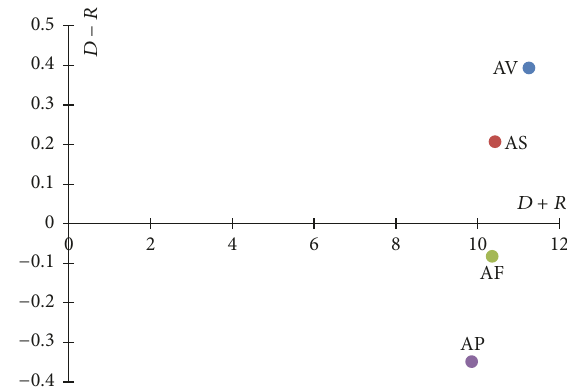
Figure 5: Cause-effect relationship diagram for 4As (Case 1 ). AV: